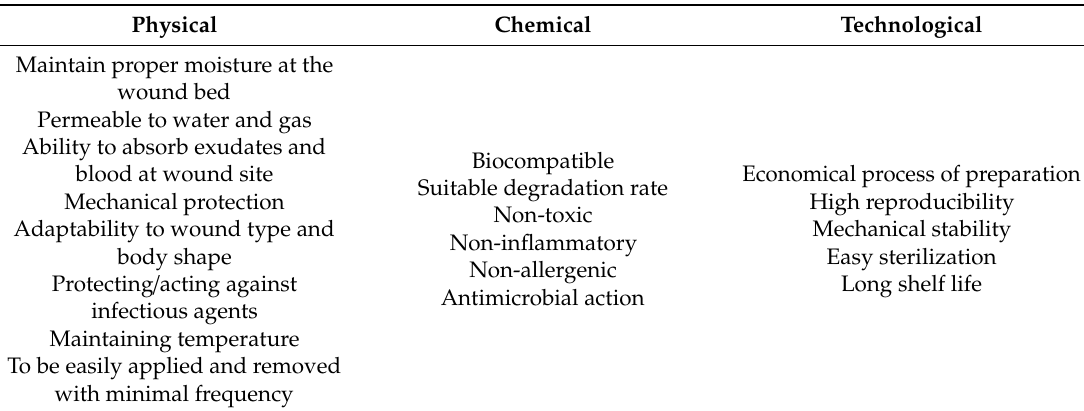
Table 2. Features of Wound